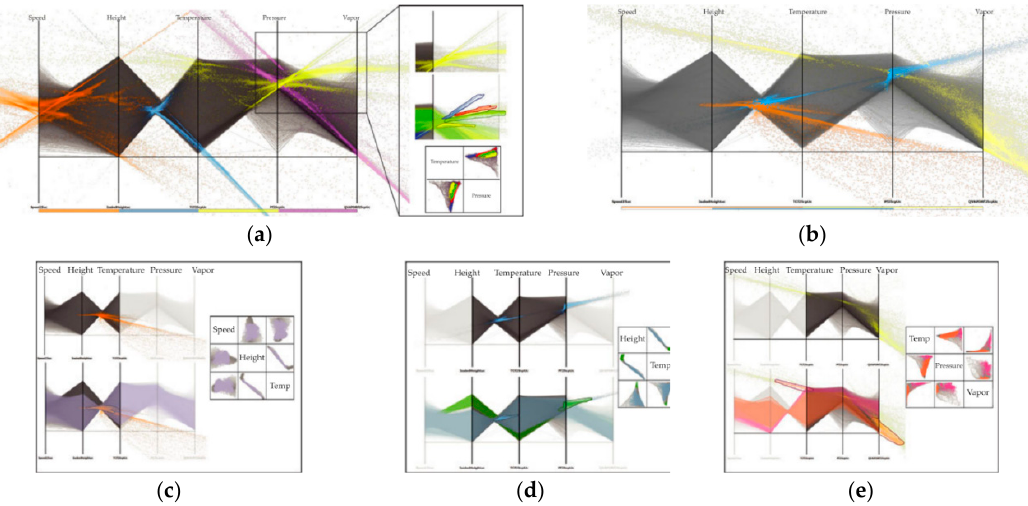
Figure 37. Visualizations of Hurricane Isabel’s trajectory dataset with five attributes: ( a ) the analysis result of one-flats, indicating positive and negative correlations between attributes; and ( b – e ) two-flats and their analysis [96].